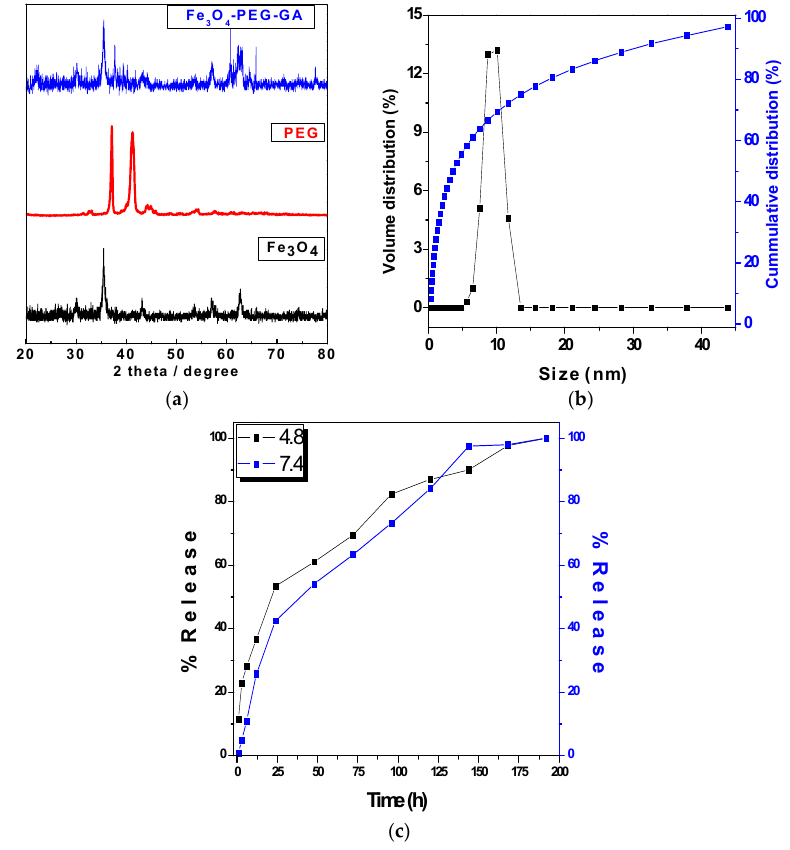
Figure 1. ( a ) X-ray Diffraction (XRD) analysis of iron oxide magnetite nanoparticles (Fe 3 O 4 ), poly ethylene glycol (PEG) and anticancer nanocomposite Fe 3 O 4 -PEG-GA; ( b ) Particle size with cumulative and volume distribution of nanocomposite Fe 3 O 4 -PEG-GA; ( c ) Release of GA from the nanocomposite [(Fe 3 O 4 )-PEG-GA)] of iron oxide magnetite nanoparticles (Fe 3 O 4 ) coated with polyethylene glycol (PEG) with loaded with gallic acid (GA) being the active anticancer agent.